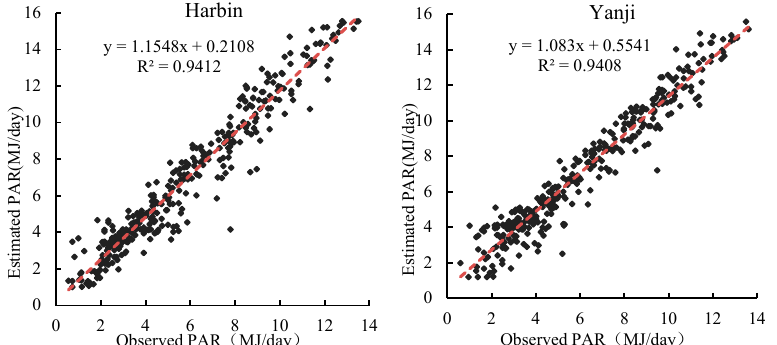
Figure 3. Variation of daily solar radiation, solar radiation top of atmosphere and solar radiation in clear sky, under different typical six stations, in 2008.